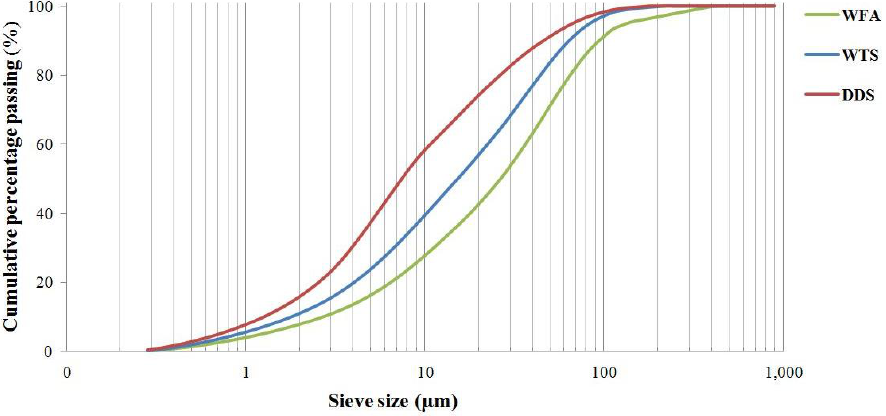
Figure 3. Particle size distributions of weathered coal fly ash, wastewater treatment sludge and desulfurization device sludge.